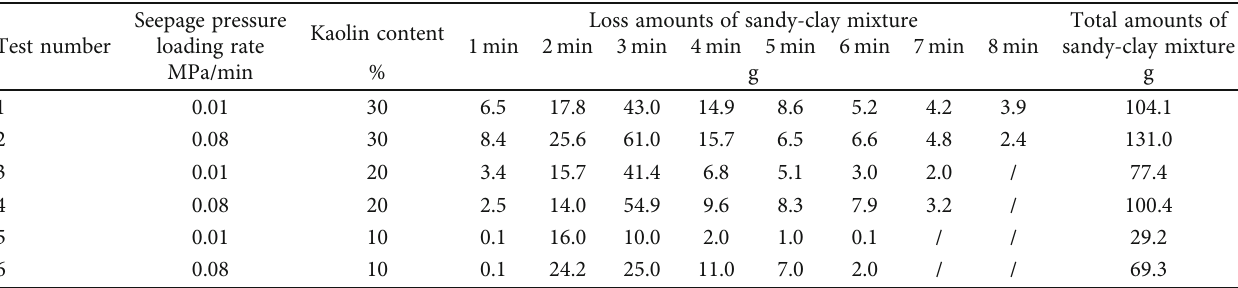
Figure 5: Water quality condition during the process of water inrush from fi lling medium. Table 5: Statistics of sand production in each